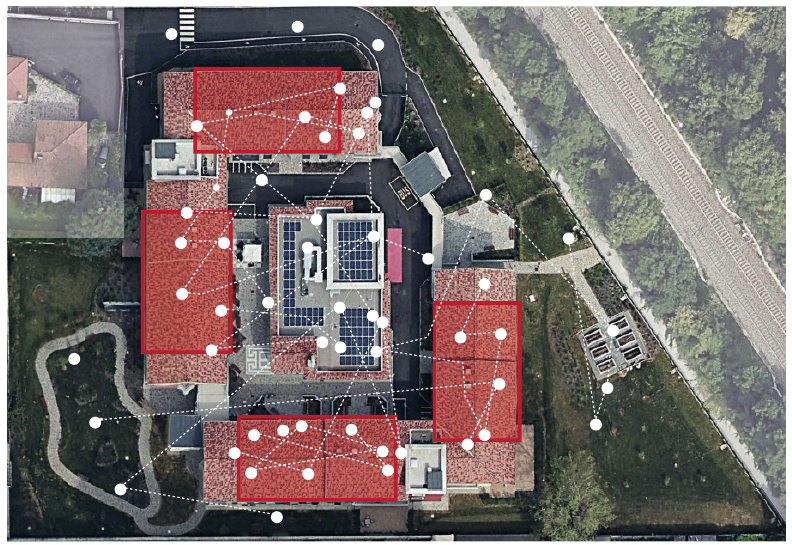
Figure 2. The network of antennas at Il Paese Ritrovato . The red areas are the private places of the structure while the white ones denote the areas outside the facility. The rest are the public areas of the facility. Notice that the top north street is the car access, so it is forbidden to